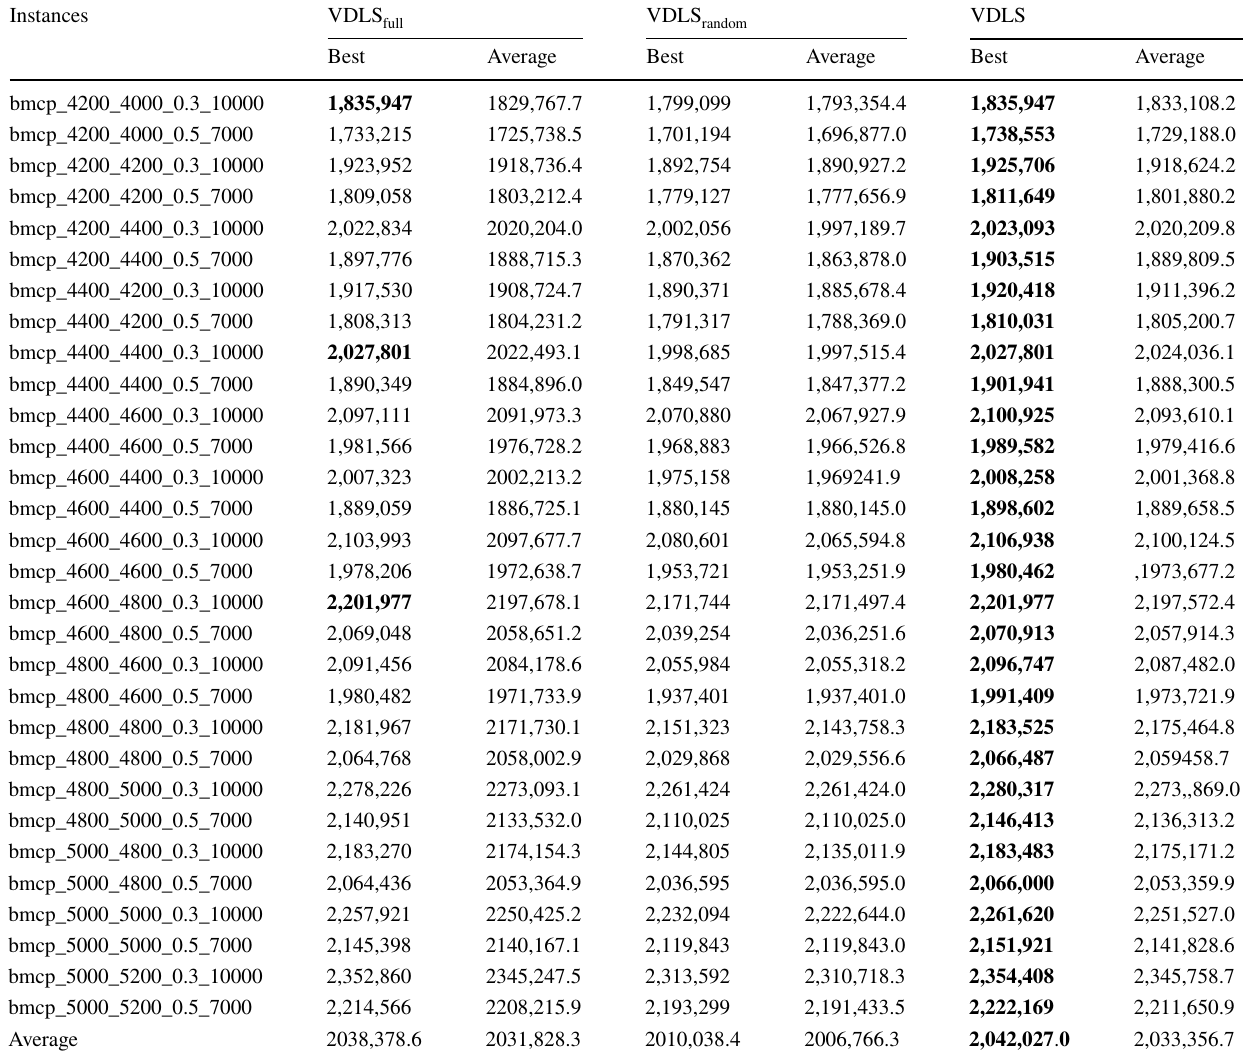
Table 8 Comparison of the VDLS and its variant algorithms, VDLS full and VDLS random , with 30 min of time limit in solving the 30 instances of the third set